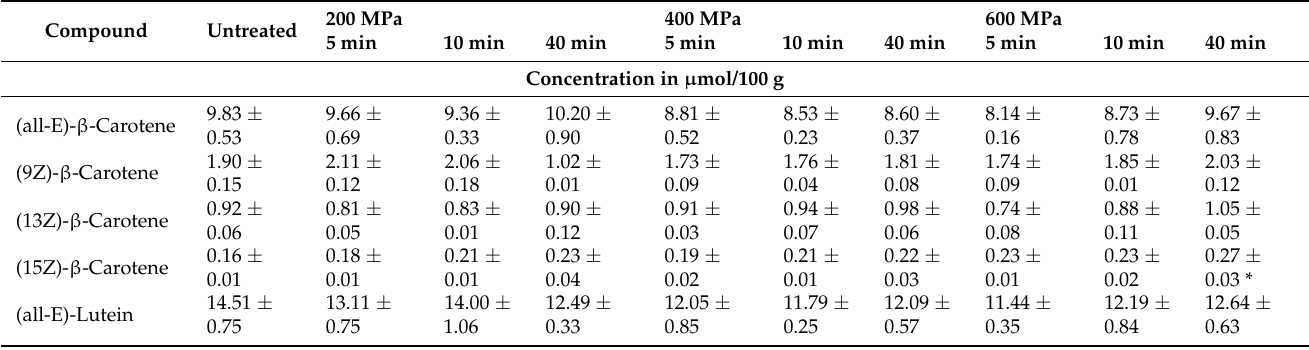
Table 2. Concentrations of carotenes, xanthophylls, and chlorophylls in treated and untreated kale in dependence on HPP parameters (200–600 MPa with holding periods of 5 min, 10 min, 40 min). One-way ANOVA with Tukey-HSD post hoc test; asterisks in the same line indicate significant differences ( p < 0.05) between treated and untreated samples.